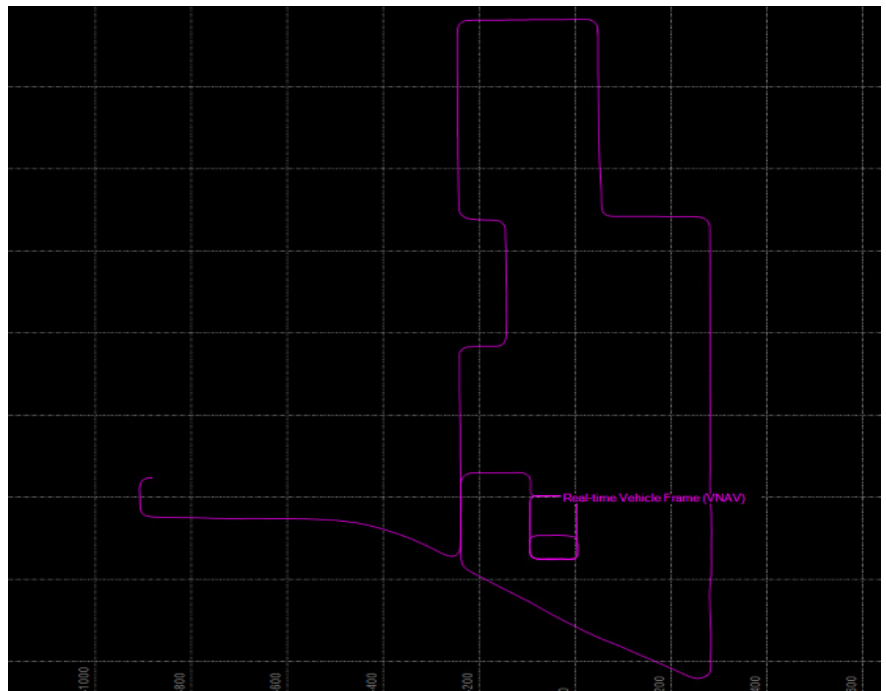
Figure 6. Example of raw data for the GNSS movement path.